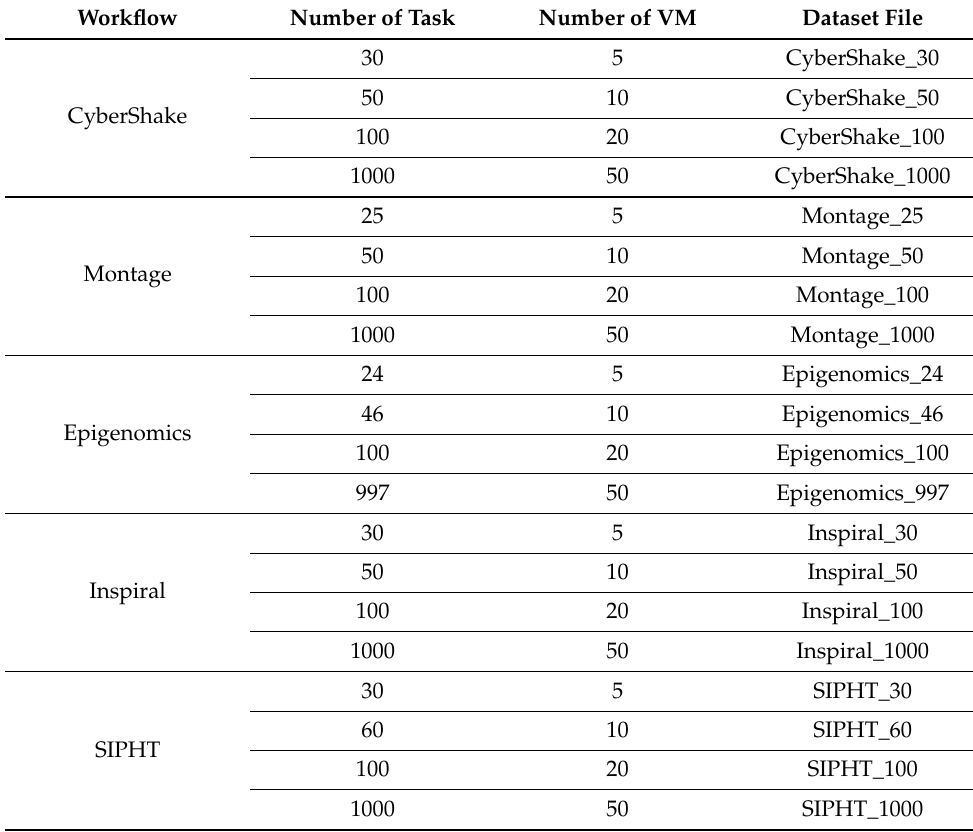
Table 5. Creation of Test Cases for different size of different